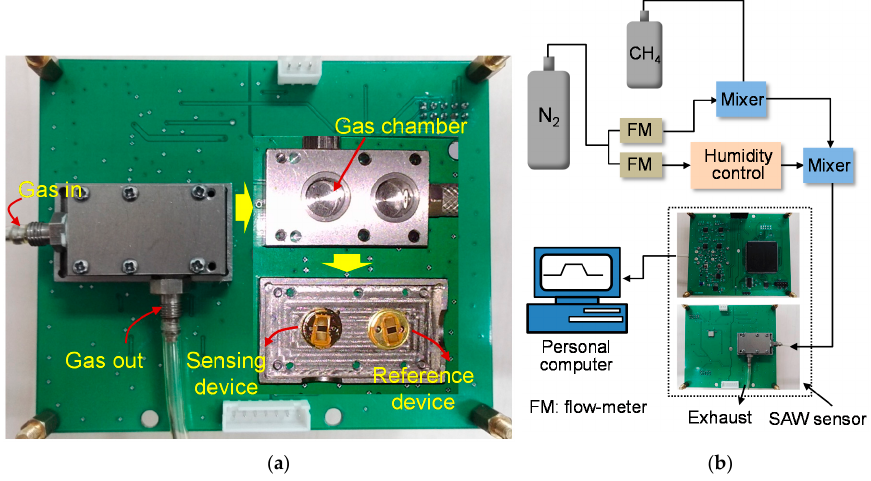
Figure 7. The gas chamber ( a ) and experimental set up ( b ) of the sensor system.